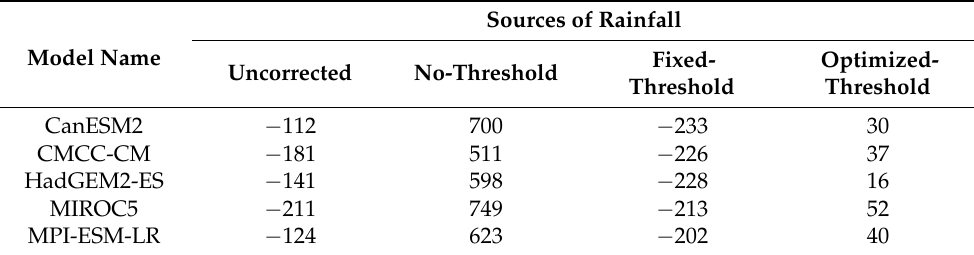
Table 7. Comparison of gap in water resources between different rainfall